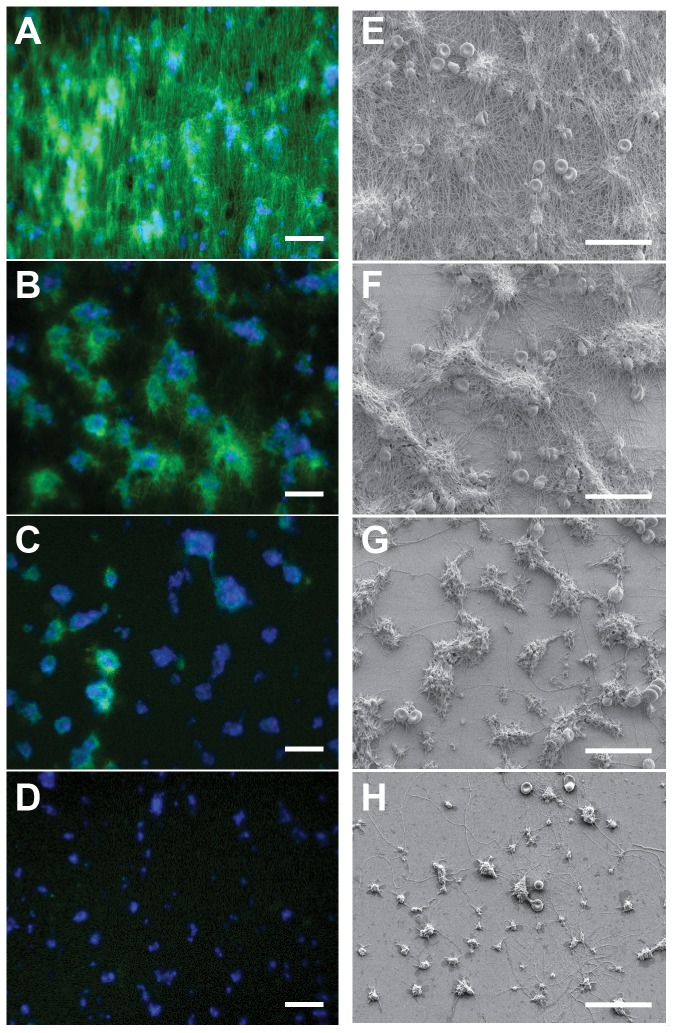
Thrombi formed under flow on collagen-TF surfaces from individuals with FVIII deficiencies.Recalcified whole blood was perfused over glass slides coated with 2.3/cm2 and type 1 fibrillar collagen at 100 s−1 for 5 min. Representative images of platelets (blue, anti-CD41) and fibrin(ogen) (green, Alexa488-fibrinogen) accumulation for a normal control (A) and hemophilia samples with plasma FVIII levels of 11.1% (B), 3.1% (C), and 0.4% (D) at 5 min. Scale bar = 25 µm. Scanning electron micrographs of thrombi from the same individuals; (E) 100% 11.1% (F), 3.1% (G), and 0.4% (H). Platelet aggregates are immersed in a fibrin mesh for the control (E) and form a starburst like pattern for mild hemophilia samples (F). The fibers on the surface in (G) and (H) are collagen fibers. Scale bar = 25 µm.